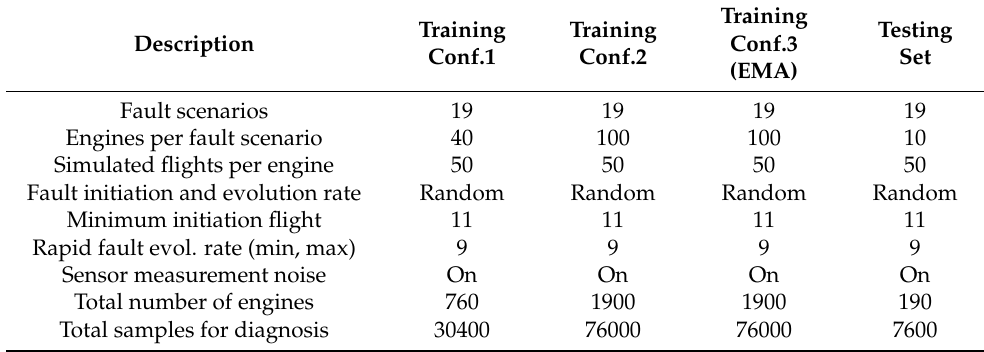
Table 5. Training and testing datasets specifications (Stage 1).